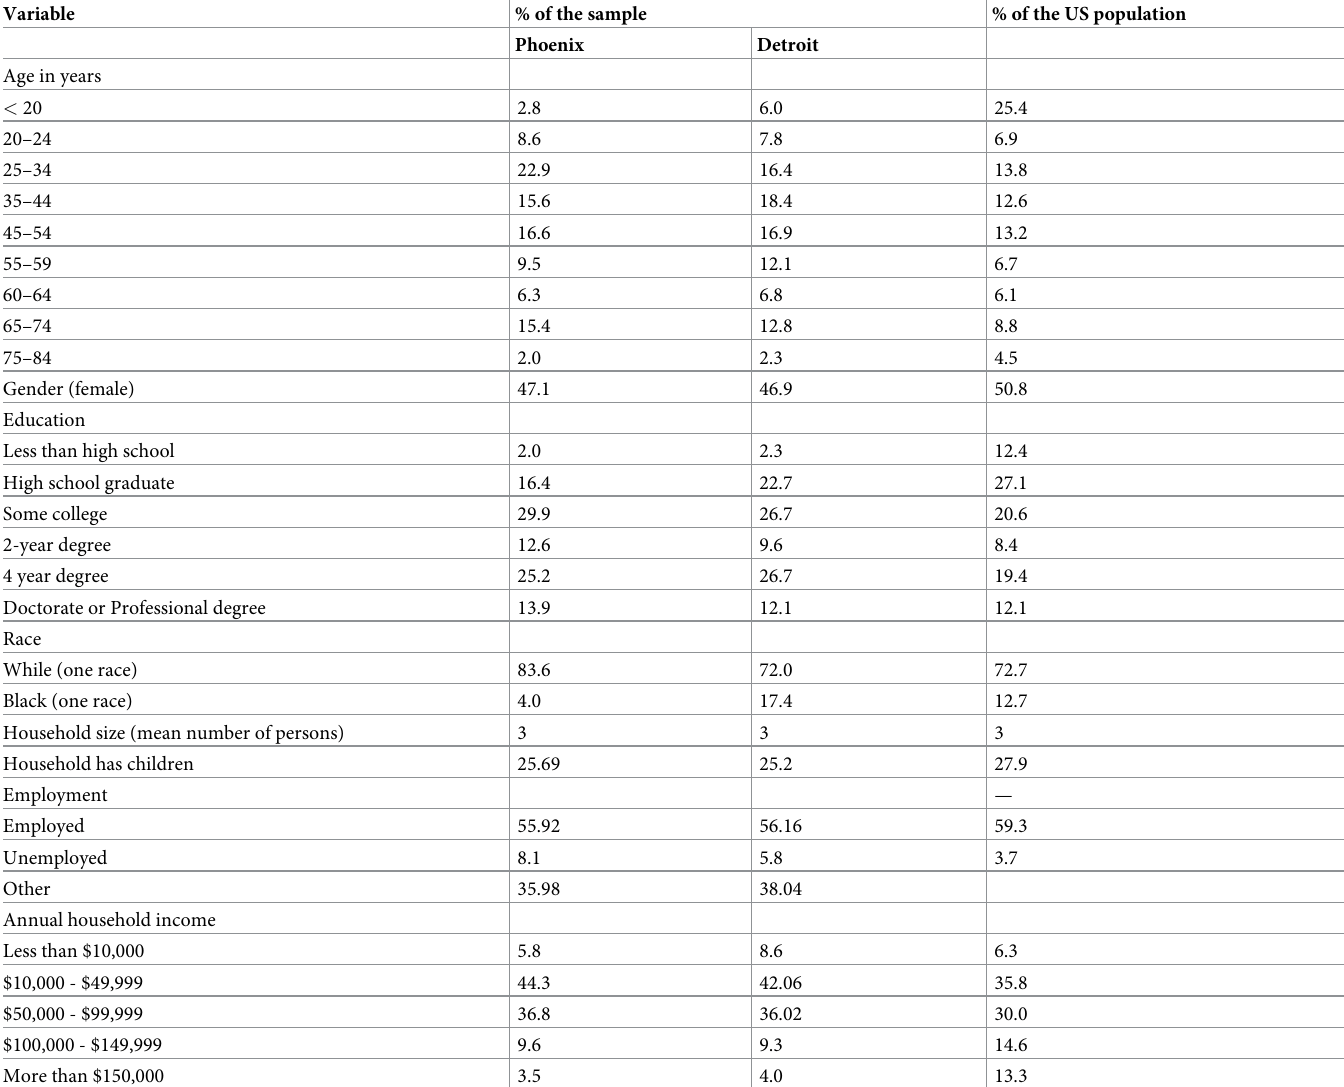
Table 1. Characteristics of survey participants in comparison to the US